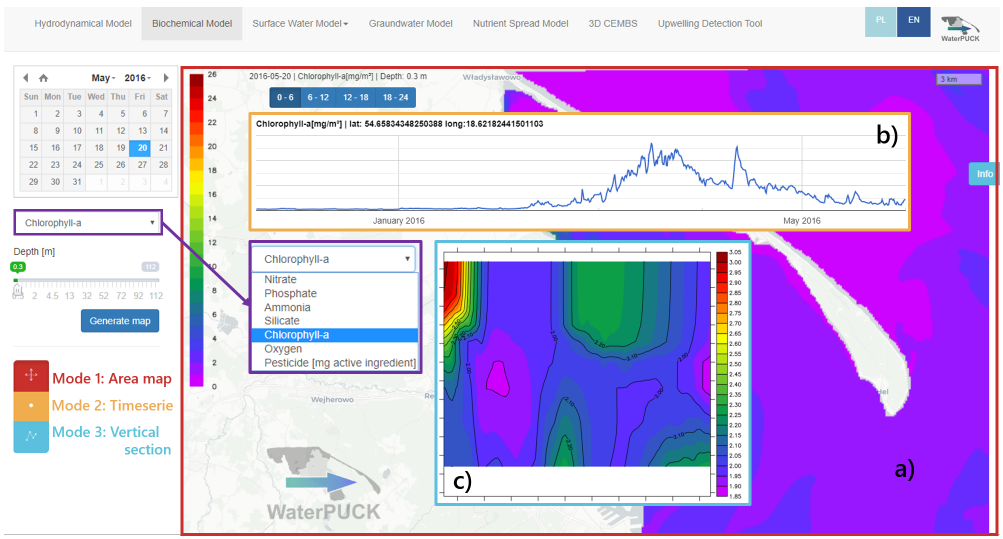
Figure 15. Screenshot of navigation menu and results for the Web Portal service: ( a ) raster map, ( b ) time series, and ( c ) vertical cross section of selected